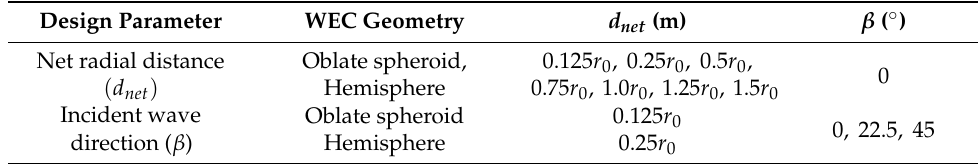
Table 2. Examined cases for the array with M = 4